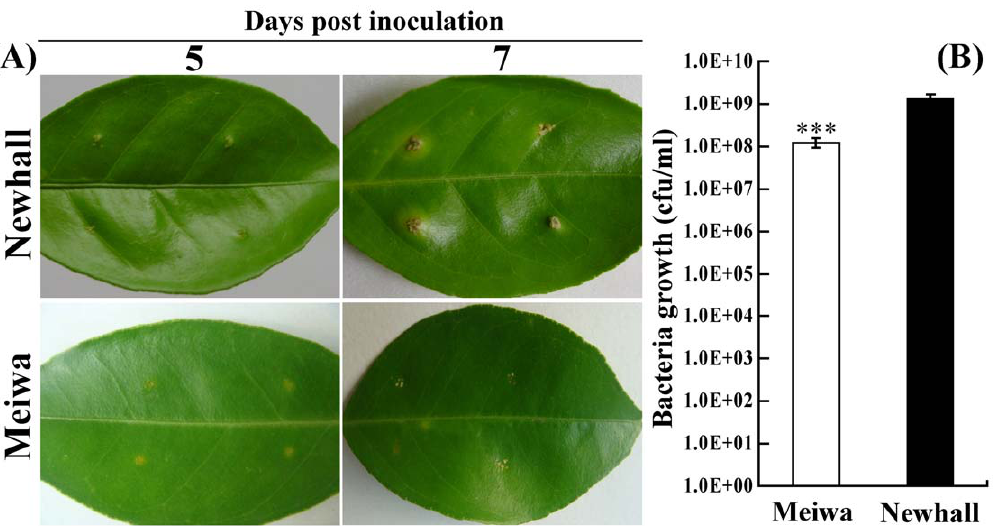
Figure 1. Comparison of canker disease development in ‘Meiwa’ and ‘Newhall’. (A) Leaves of ‘Meiwa’ and ‘Newhall’ were pinprick- inoculated with citrus canker bacterium and periodically observed within 7 d, and the pictures were taken at 5 and 7 days post inoculation (DPI). (B)